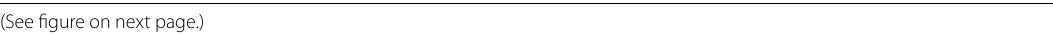
independently(See figure on next Fig. 6 EVs-miR-182-5p induces proliferation, migration and angiogenesis of HUVECs through inhibition of CMTM7 and activation of the EGFR/AKT signaling pathway. A Venn diagram of genes related to CMTM7 expression in breast cancer tissue samples from dataset GSE50428, MEM database and LinkedOmics database; B PPI network of 98 intersection genes related to CMTM7 expression constructed using String (in the PPI network, the higher core degree is, the more red the circle color is; otherwise, the lower the core degree, the bluer the color is); C Expression of CMTM7, VEGF, p-EGFR, EGFR, p-AKT and AKT in HUVECs treated with EVs or combined with miR-182-5p inhibitor by Western blot analysis, the statistical power was 1; D Expression of CMTM7, VEGF, p-EGFR, EGFR, p-AKT and AKT in HUVECs treated with EVs or combined with GDC0068 detected by Western blot analysis, the statistical power was 1; E Proliferation of HUVECs treated with EVs or combined with GDC0068 detected by CCK-8 method, the statistical power was 1; F Migration of HUVECs treated with EVs or combined with GDC0068 detected by scratch test, the statistical power was 1; G Migration ability of HUVECs treated with EVs or combined with GDC0068 detected by Transwell assay, the statistical power was 1; H Vessel-like tube formation in vitro of HUVECs treated with EVs or combined with GDC0068, the statistical power was 1. * p < 0.05, ** p < 0.01, *** p < 0.001, **** p < 0.0001 compared with control HUVECs, or HUVECs treated with PBS or EVs inhibitor NC. # p < 0.05, ## p < 0.01, ### p < 0.001 compared with + HUVECs treated with DMSO-EVs. The experiment was conducted three times